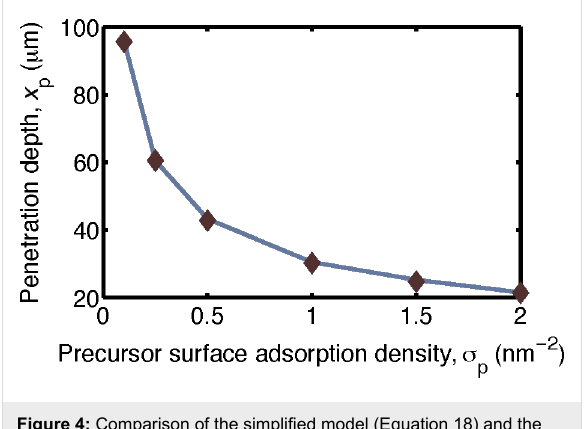
Figure 4: Comparison of the simplified model (Equation 18) and the simulation of the full diffusion model (solid line) while using a reactive sticking coefficient Γ = 1, as function of the varying precursor surface adsorption density. The penetration depths given by both methods are in